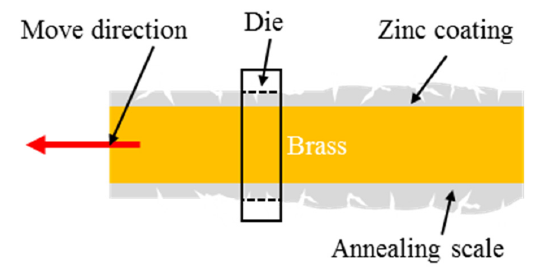
Figure 3. The schematic diagram of plastic processing during preparing zinc coating.